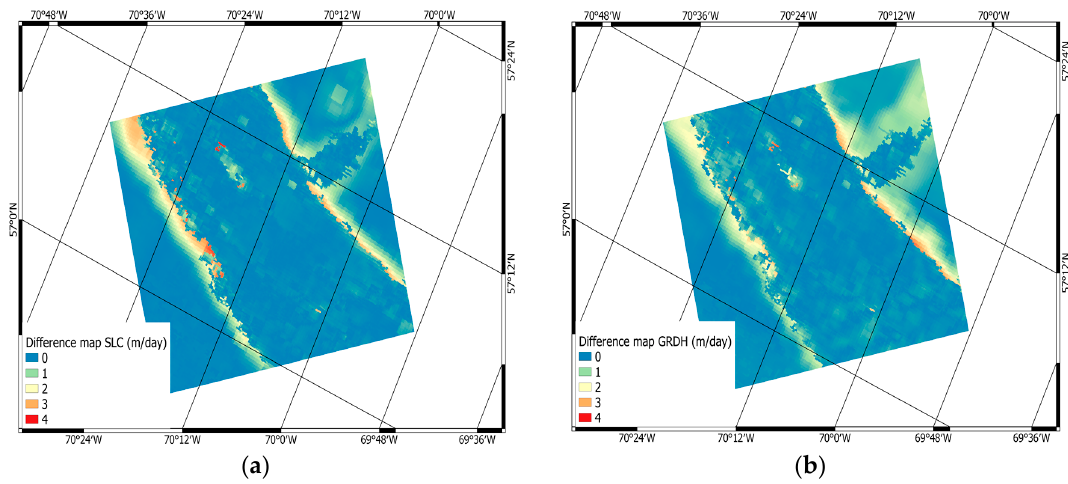
Figure 5. PG, velocity difference map relevant to the observation period 6–12 January 2017 between the implemented frequency domain OT and reference data for ( a ) SLC and ( b ) GRDH image input.